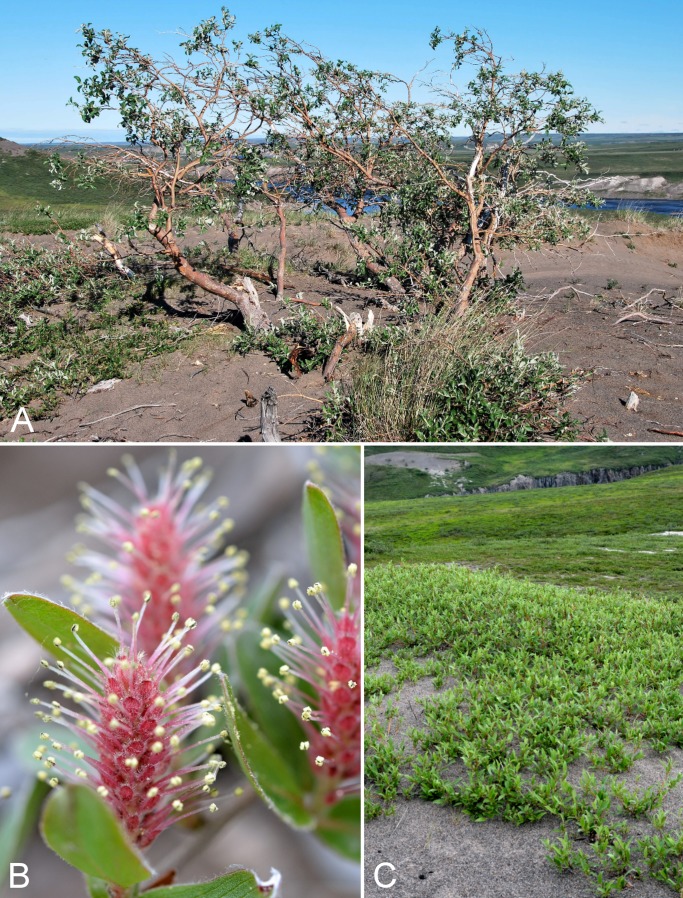
Salix alaxensis var. alaxensis and Salix niphoclada.Salix alaxensis var. alaxensis: (A) habit, Saarela et al. 4191. Salix niphoclada: (B) staminate catkins, Saarela et al. 4019. (C) Habit, Saarela et al. 4019. Photographs by J. M. Saarela (A), R. D. Bull (B), and P. C. Sokoloff (C).